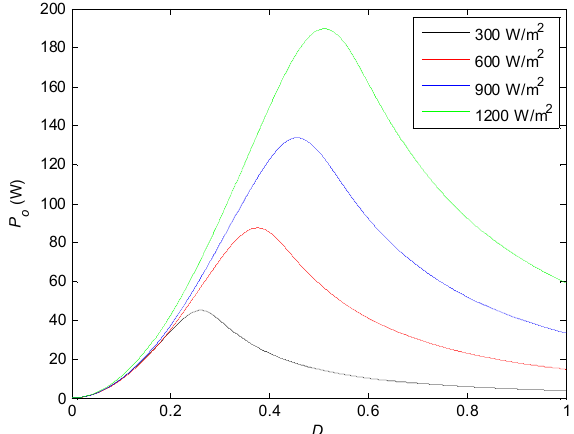
Figure 2. curves under different irradiance conditions.